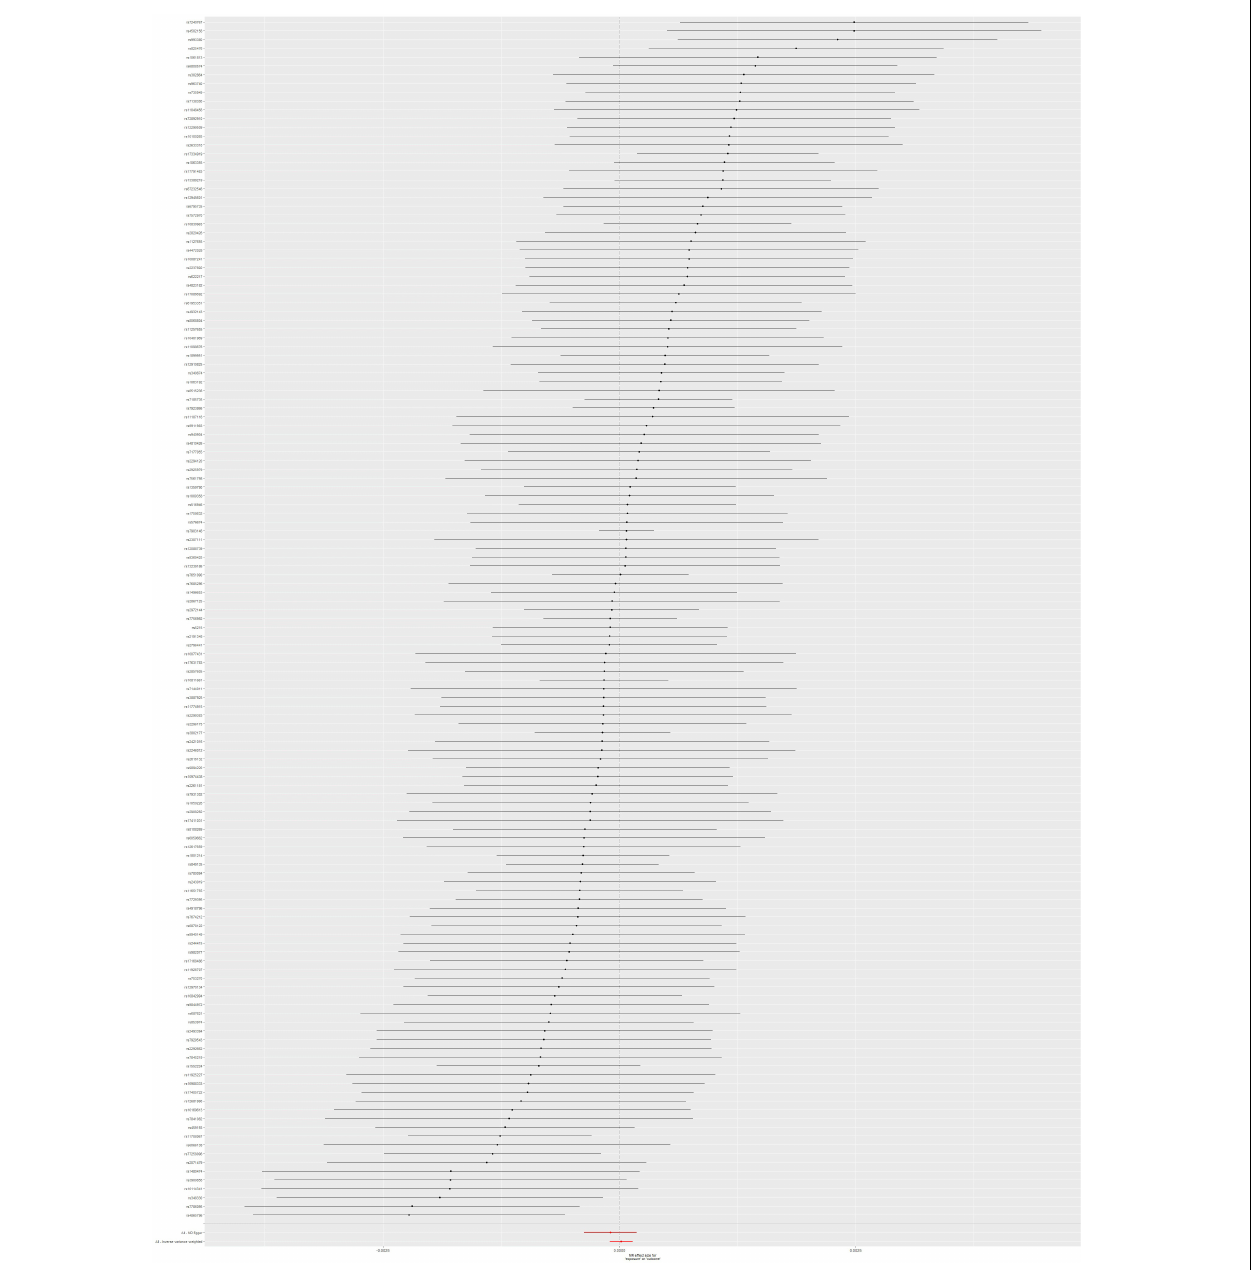
FIGURE 6 | Forest plot: the associations between T2DM-related SNPs and GUI risk in pregnancy. T2DM, type 2 diabetes mellitus; GUI, genito-urinary infection; SNPs, single-nucleotide polymorphisms; OR, odds ratio; CIs, confidence